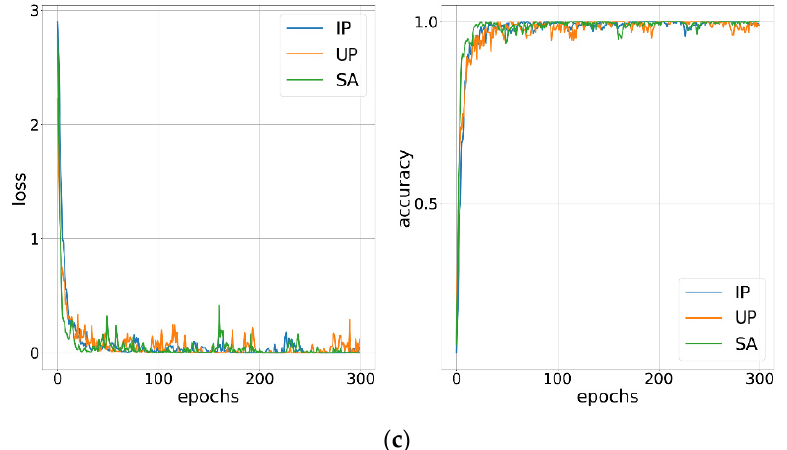
Figure 11. Training process for different number of training samples, ( a ) Training process for sample = 5; ( b ) Training process for sample = 10; ( c ) Training process for sample = 15.